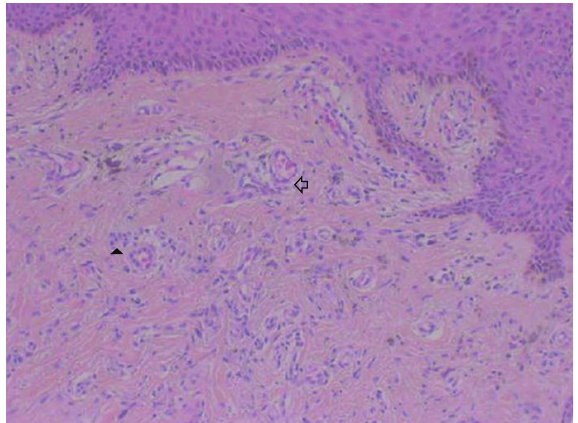
Figure 2: 100x; histopathology showing perivascular lymphocytic infiltrate (arrow head) and thick-walled capillaries (hollow